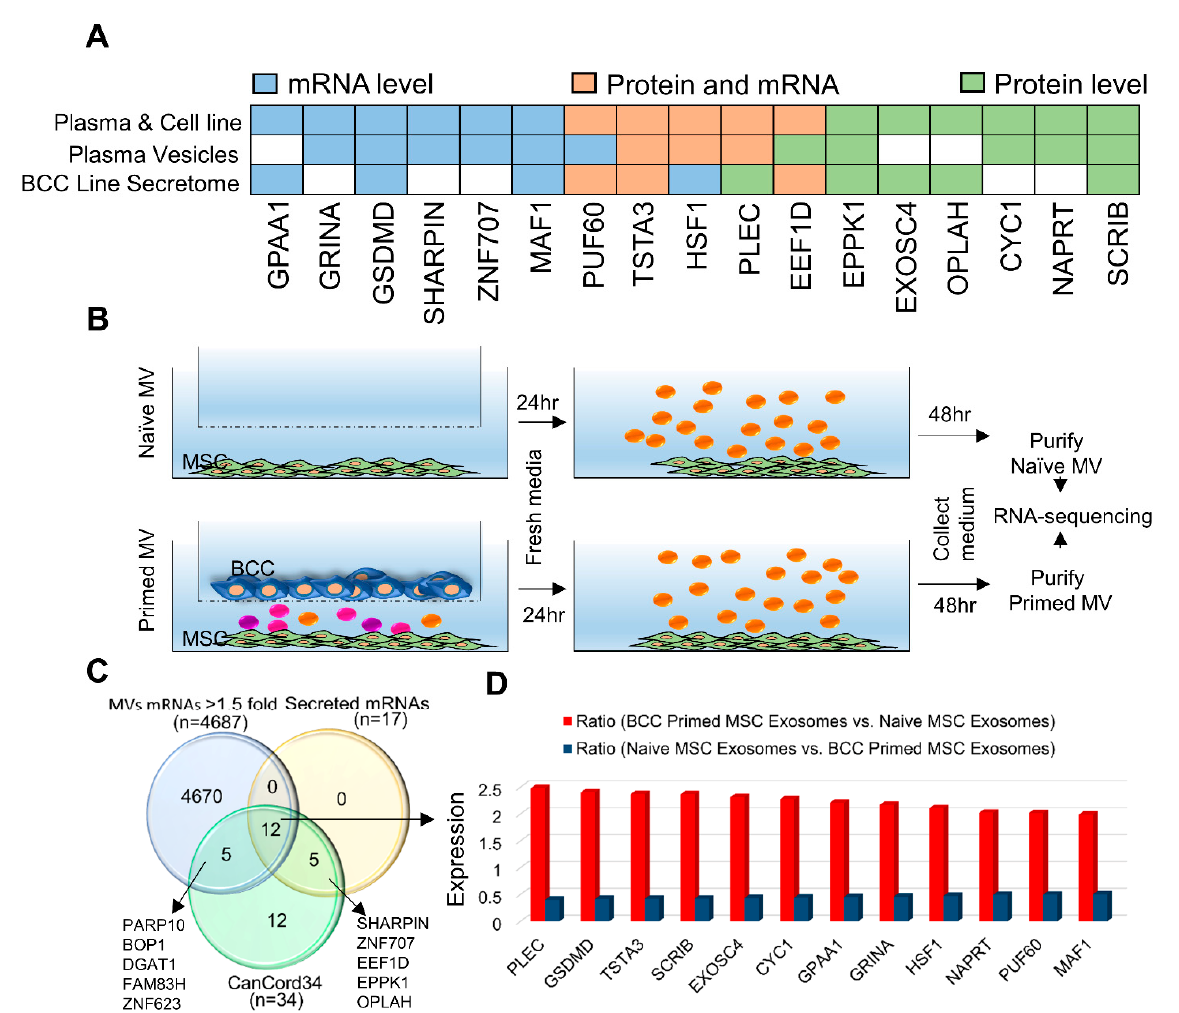
Figure 6. CanCord34 in secretory functions. ( A ) The literature curation of CanCord34 genes shows a subset of CanCord34 genes as secreted mRNA, proteins, or both. ( B ) Cartoon showing the model system used. ( C ) Venn diagram showing the overlap of the 12 upregulated mRNAs present in MSC-derived extracellular vesicles ( n = 4686, >1.5-fold with a p -value 0.05), secreted CanCord34 mRNAs and/or proteins identified in public databases ( n = 17), and CanCord34 genes ( n = 34). ( D ) Bar chart showing the upregulation of 12 secreted CanCord34 genes in MSCs incubated with primed exosomes vs. naïve MSC exosomes.